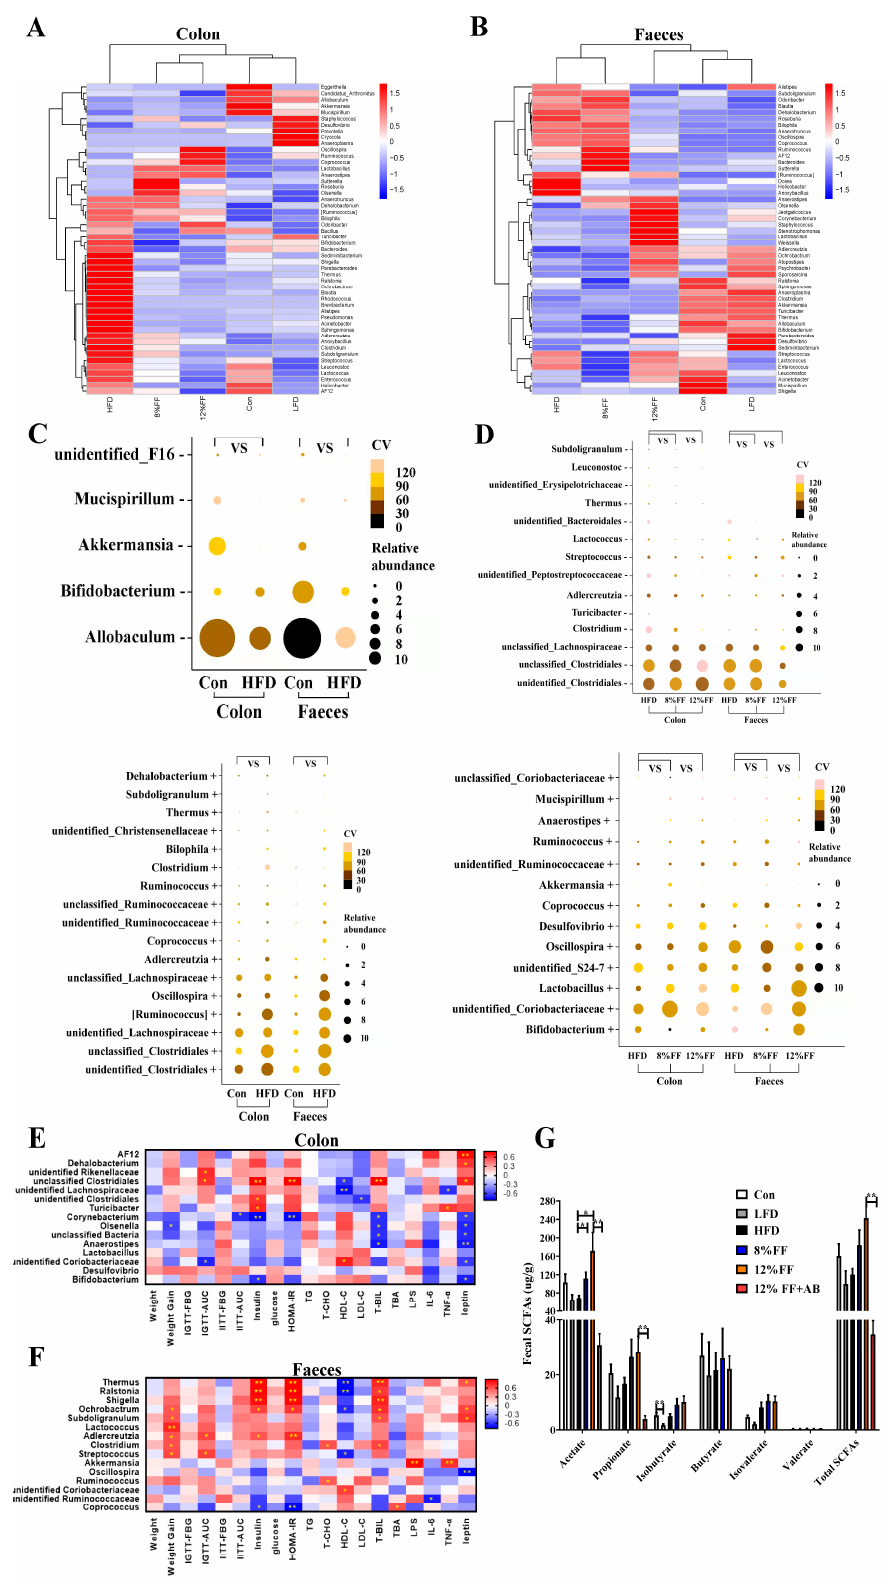
Figure 6. Effects of functional fiber on the genus of fecal microbiota in obese mice ( n = 6). ( A , B ) The heat maps of genus composition of colonic microbial and fecal microbial species clusters. ( C , D ) Bacteria with abundance decrease (top) and increase (below) in HFD group vs. Con group and 12% FF group